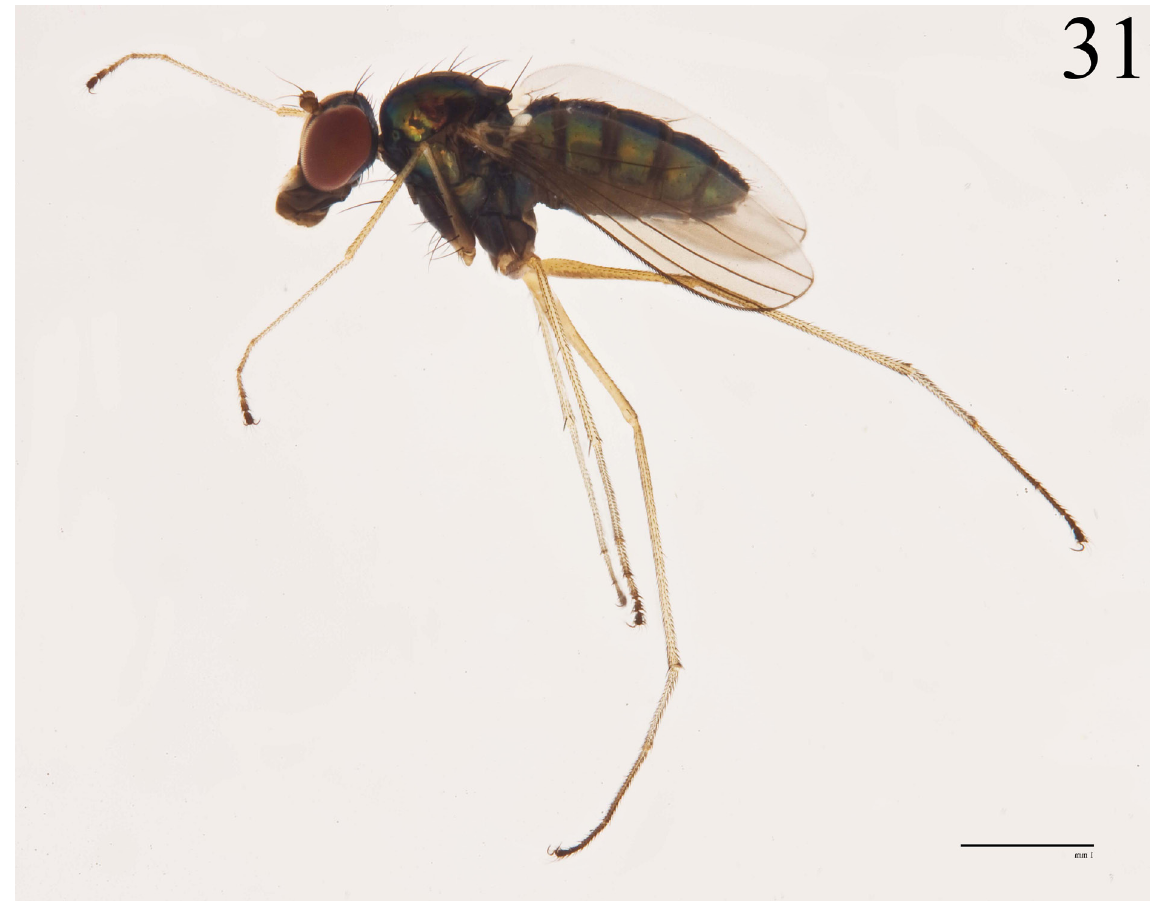
Fig. 31. Thinophilus spinatus sp. nov., ♀,